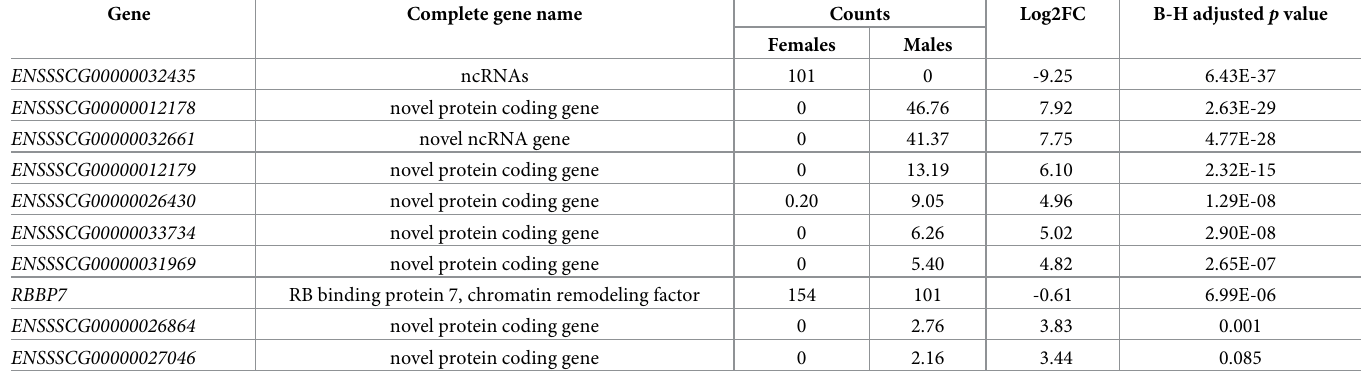
Table 3. Ten significant differentially expressed genes (B-H adjusted p value < 0.1) calculated with DESeq2 from hypothalamic transcriptome data of 60 days-old pure Iberian and Iberian x Large White crossbreds pigs comparing females vs males.